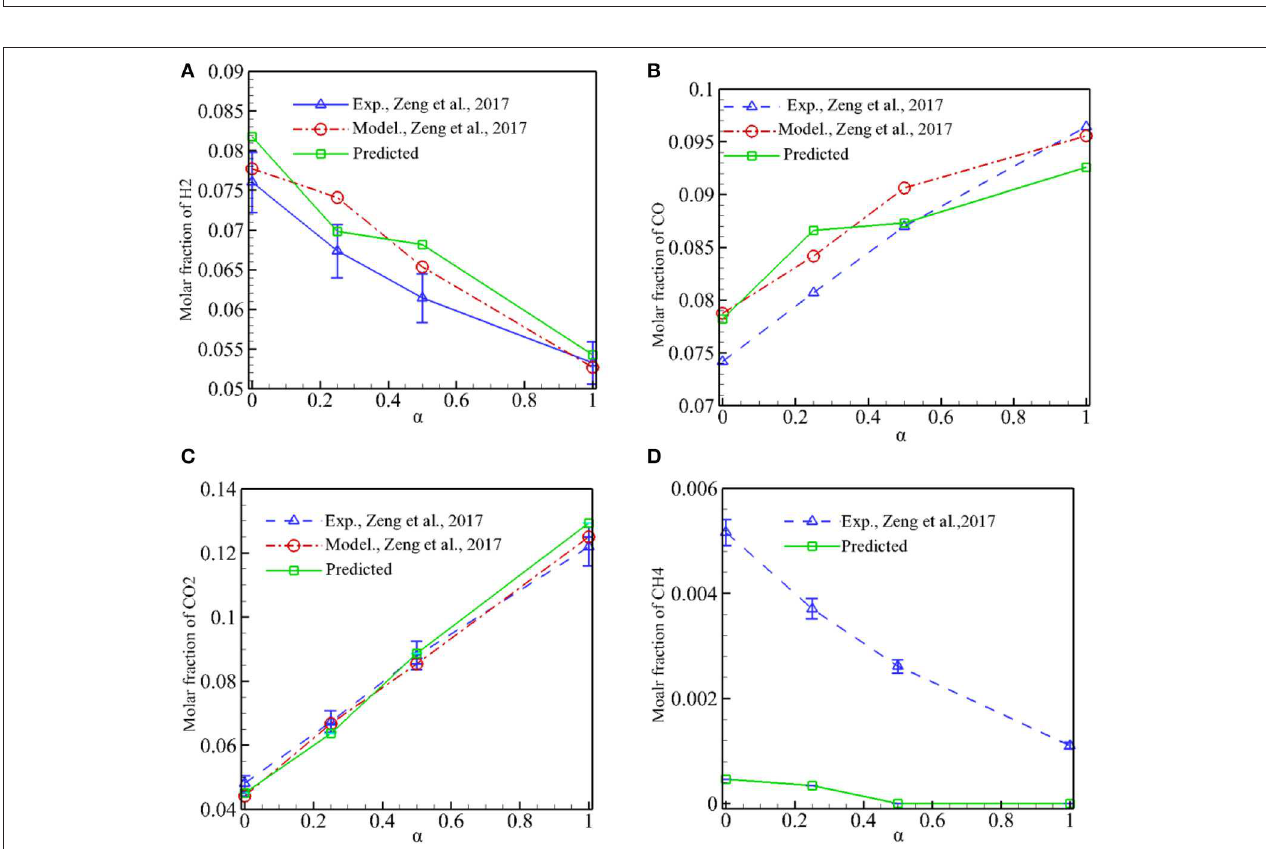
1.5 and α 0, 1. (A) Predicted temperatures for α = =